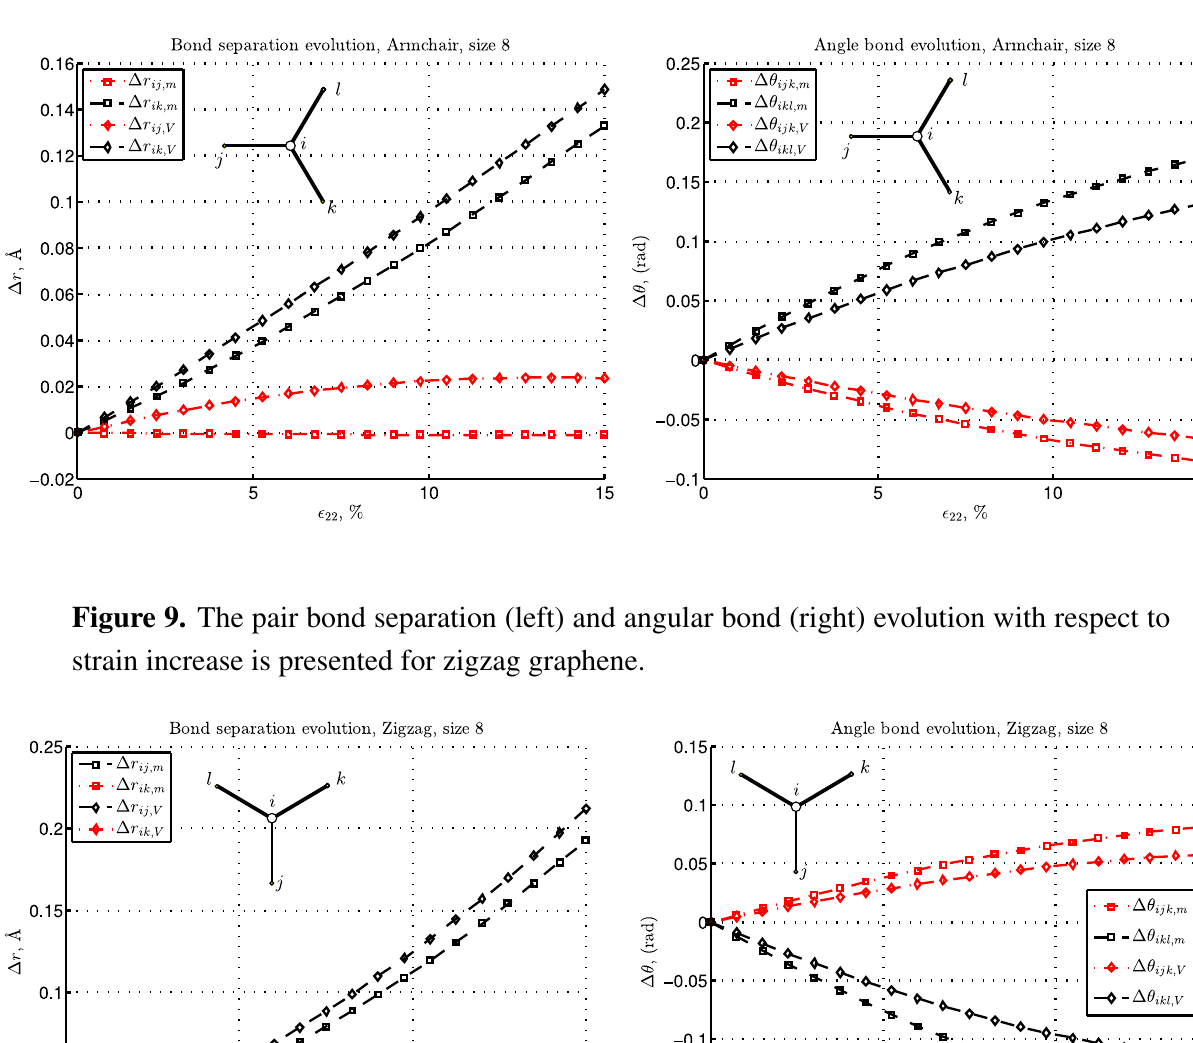
Figure 8. The pair bond separation (left) and angular bond (right) evolution with respect to strain increase for armchair graphene.